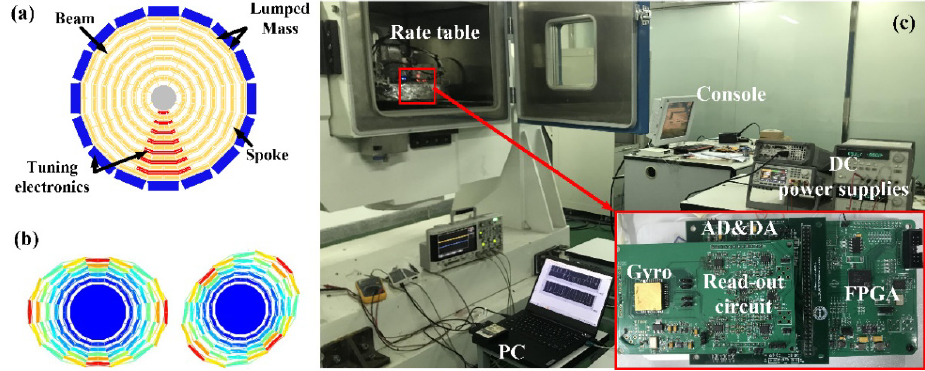
Figure 6. ( a ) Structure and ( b ) mode shapes of the n = 2 wineglass modes of the CDRG. ( c ) Test platform and control circuit. The control circuit includes the interface circuit to extract gyro signals, an ADC, and a DAC for the conversion of digital and analog signals and an FPGA to realize the control program.